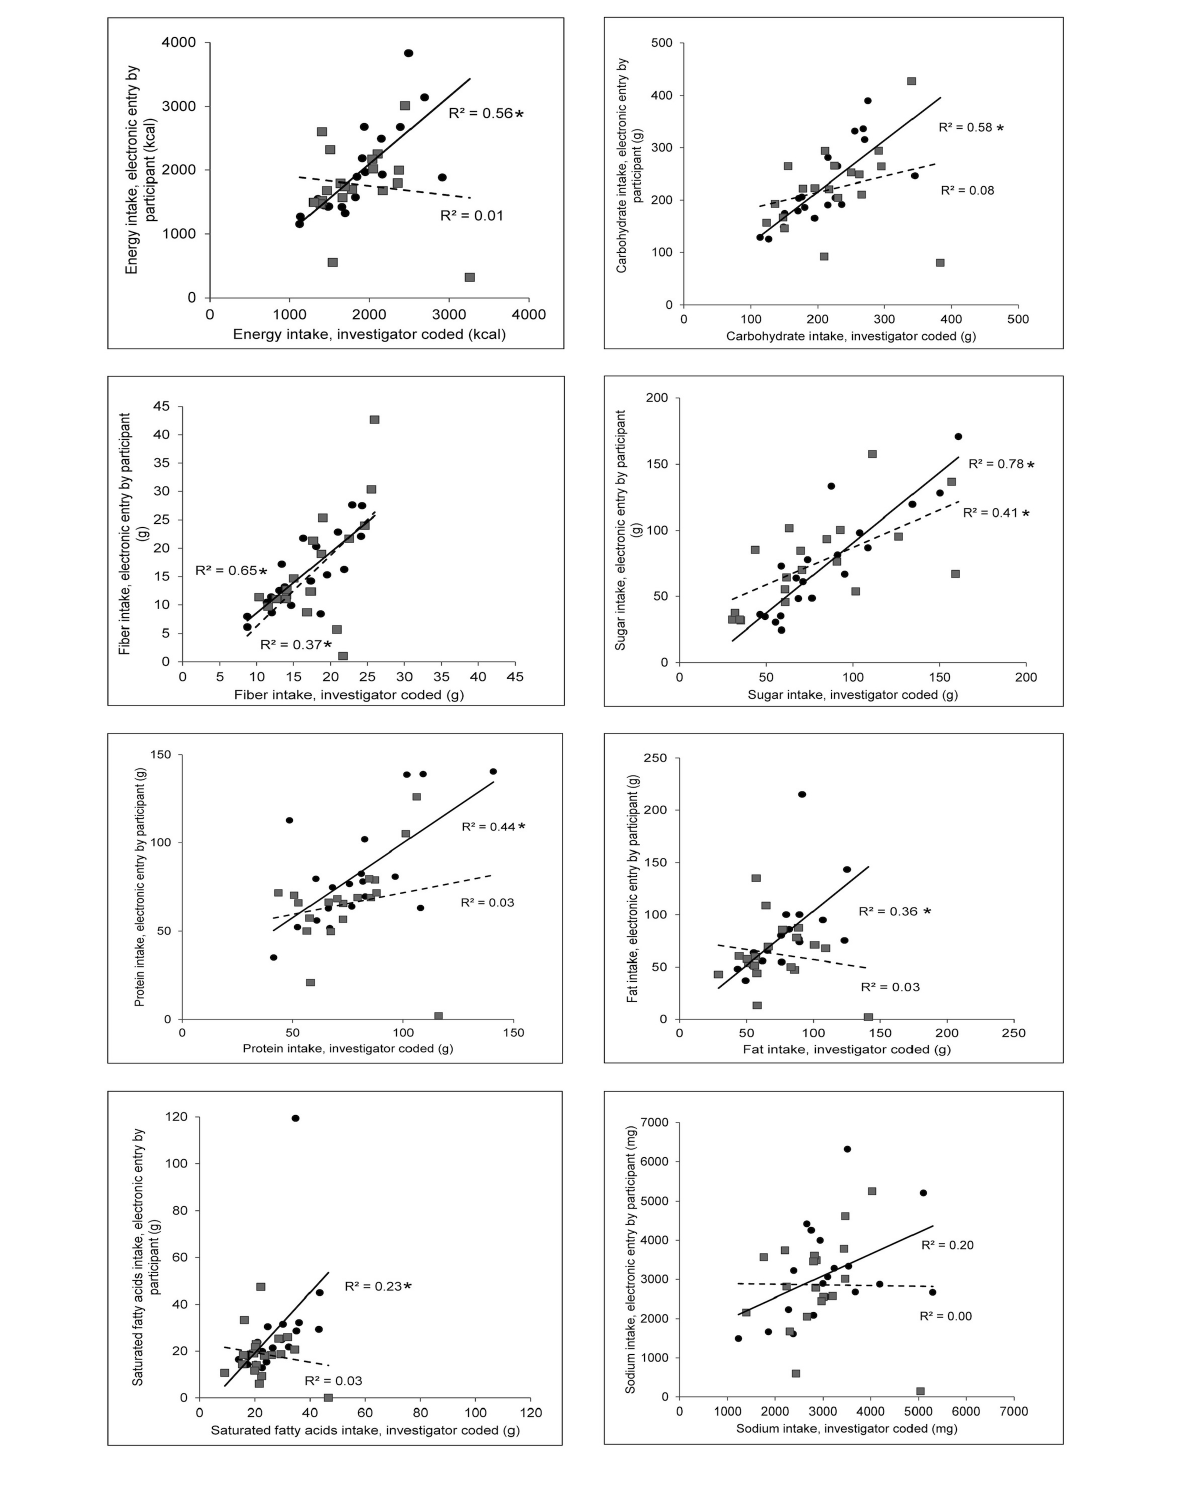
Figure 4. Plots comparing nutrient intakes estimated from 3-day diet records coded by investigator to same 3-day diet records entered electronically: Comparing Nutrihand (black circle) or Tap & Track (grey square) to Grand Forks Research Analysis of Nutrient Data (GRAND). Each point represents mean of food records for 3 days for each individual (n=19). Regressions comparing intake estimates from Nutrihand (solid line) and Tap & Track (dashed line) to estimates obtained from investigator-coded records were performed and R2 values are reported. *Statistical significance at